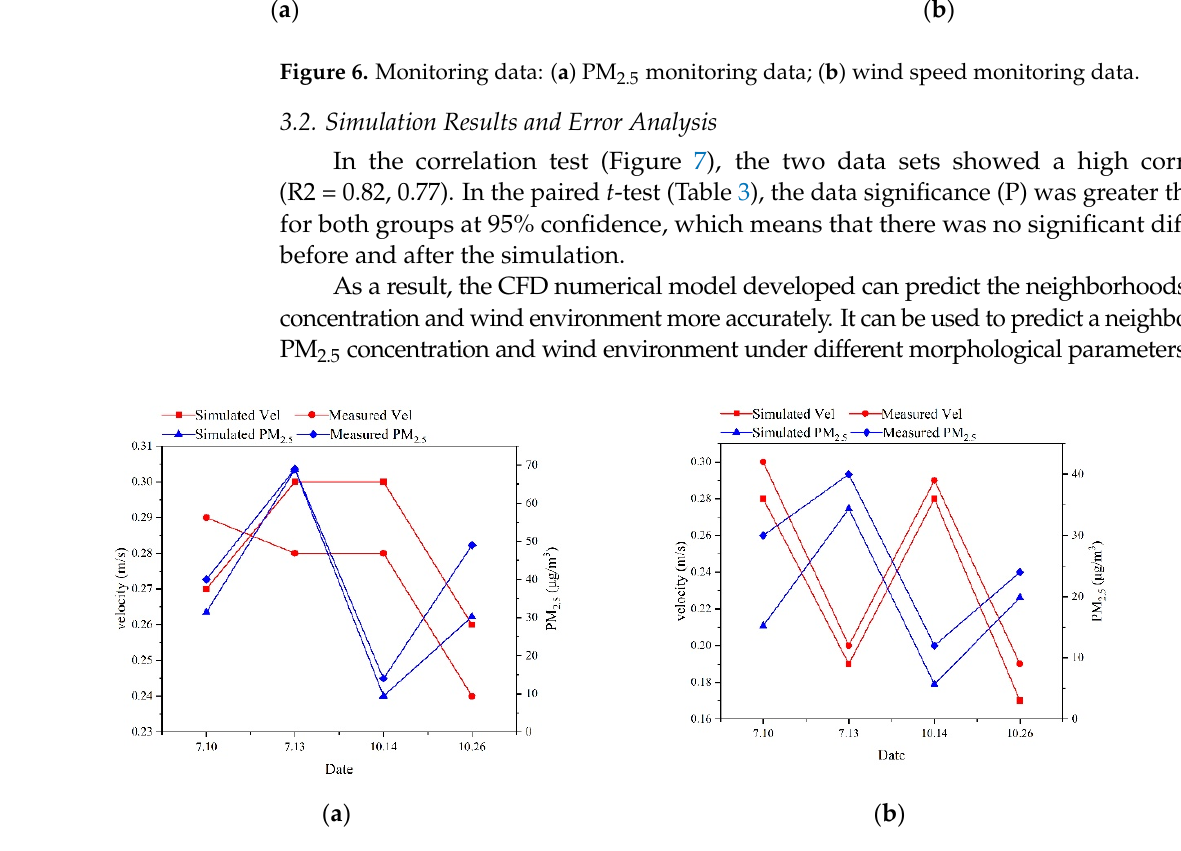
Figure 7. Correlation test before and after simulation of: ( a ) Neighborhood A; ( b ) Neighborhood B. Table 3. P1 and P2 simulated data were paired with measured data for the sample test.